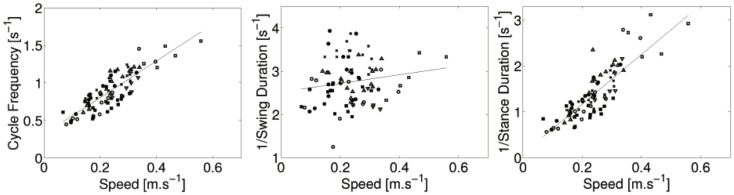
Cycle frequency, 1/stance duration, and 1/swing duration as a function of the speed of locomotion for all subjects: ● for infant A, ○ for B, ♦ for C, ◇ for D, ■ for E, □ for F, and × for G. Regression lines are also showed. The strong linear correlation between locomotion speed and cycle frequency (resp. 1/stance duration) is noticeable.